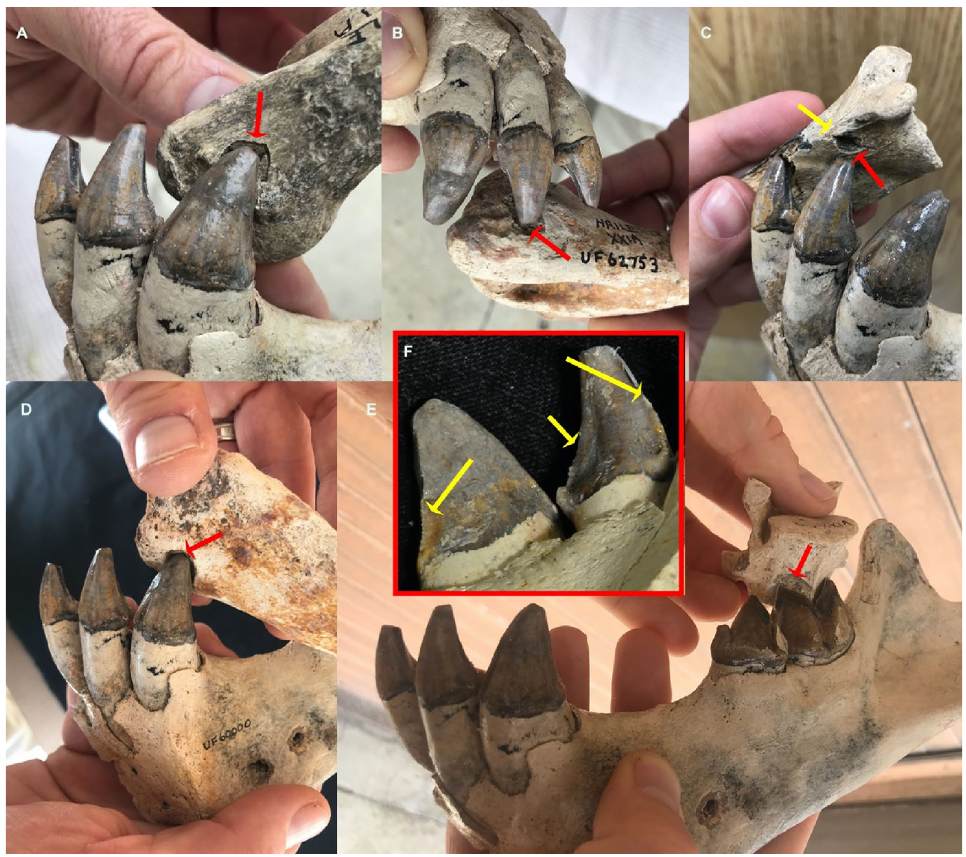
Figure 3. Examples of large tooth marks that fit the size of the Xenosmilus anterior dentition (incisors and canines) ( A–D ). These marks are found on the medial side of the distal epiphysis of humeri ( A, B ) and on the neck of scapulae ( C ). They are also documented on the proximal tibia ( D ). A mark that fits the size and shape of the carnassial crest has also been documented on a vertebra ( E ). Xenosmilus had very large incisors with serrated edges ( F ) (yellow arrows). They are positioned in a protruding curved arcade. The serrated edges on the carinated incisors and lower canines resulted in frequent bisectioning of the resulting tooth marks (see, for example, the tooth mark on the scapular neck in (yellow arrow in C ).